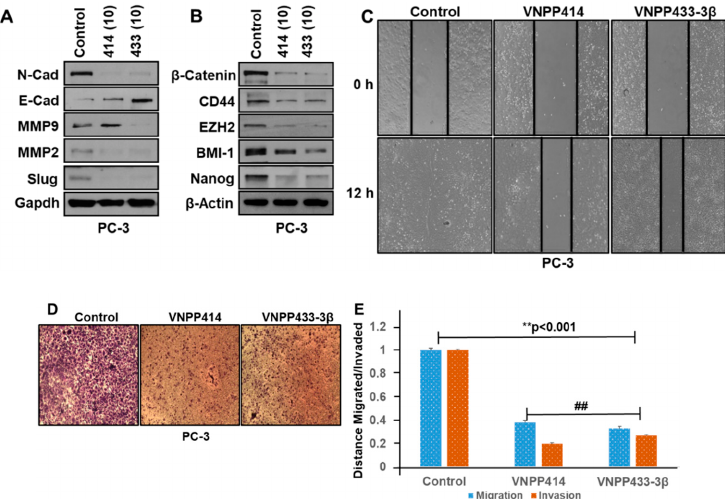
Figure 5. NGGAs modulate epithelial-to-mesenchymal transition (EMT) markers and inhibit cell migration and invasion. ( A ) VNPP414 (414) and VNPP433-3 β (433) induce expression of E-cadherin and decreased expressions of N-cadherin, MMP2, MMP9, and Slug. ( B ) VNPP414 (414) and VNPP433-3 β (433) decreased expressions of β -catenin, CD44, EZH2, BMI-1, and Nanog. ( C ) VNPP414 and VNPP433-3 β inhibit PC cells migration. ( D ) VNPP414 and VNPP433-3 β inhibit PC cells invasion. ( E ) Quantifications of inhibition of cell migration and invasion by VNPP414 and VNPP433-3 β . Note: the numbers in parentheses in Figure 5A,B are concentrations of the agents in µM.